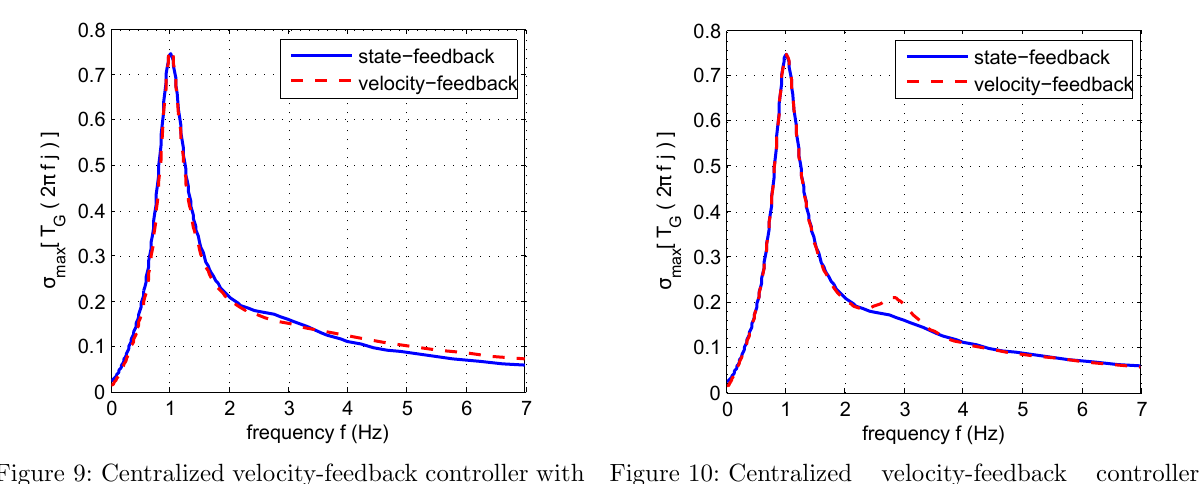
Figure 10: Centralized velocity-feedback controller with L = (cid:101) L . Maximum singular values of the closed-loop pulse transfer functions corresponding to the centralized velocity- feedback controller u ( t ) = (cid:101) K y ( t ) (red dashed line) and the optimal state-feedback controller u ( t ) = (cid:101) G s x ( t ) (blue solid line) the γ -value in eq. (72) and the upper bound in eq. (90) indicate that the velocity-feedback controller